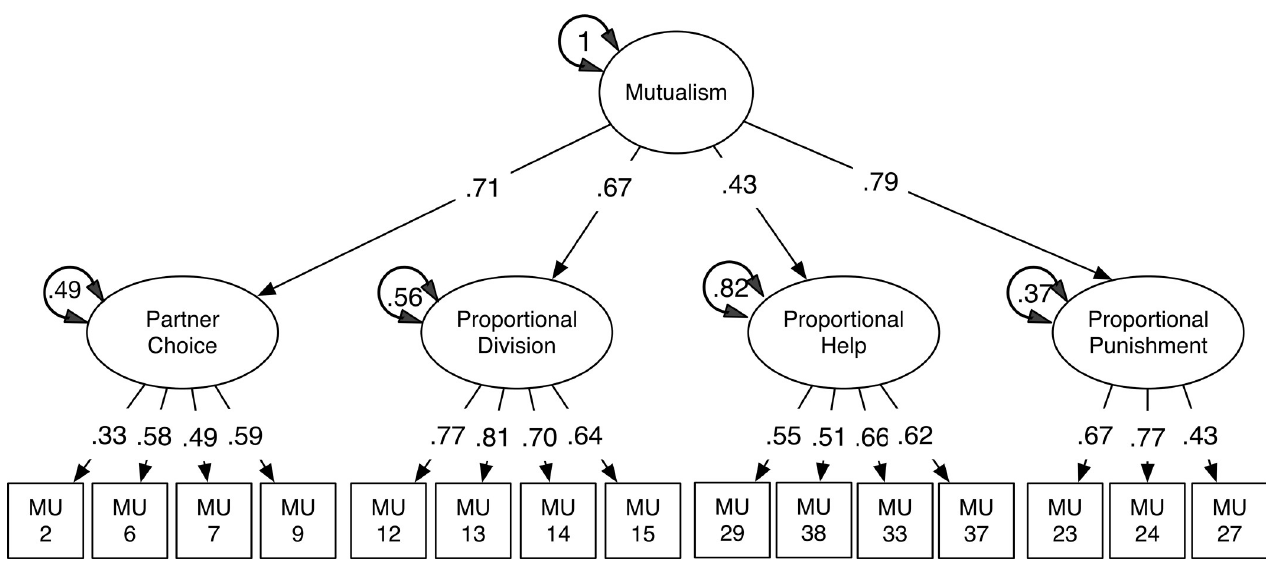
Fig 1. Well-fitting measurement model of mutualism, study